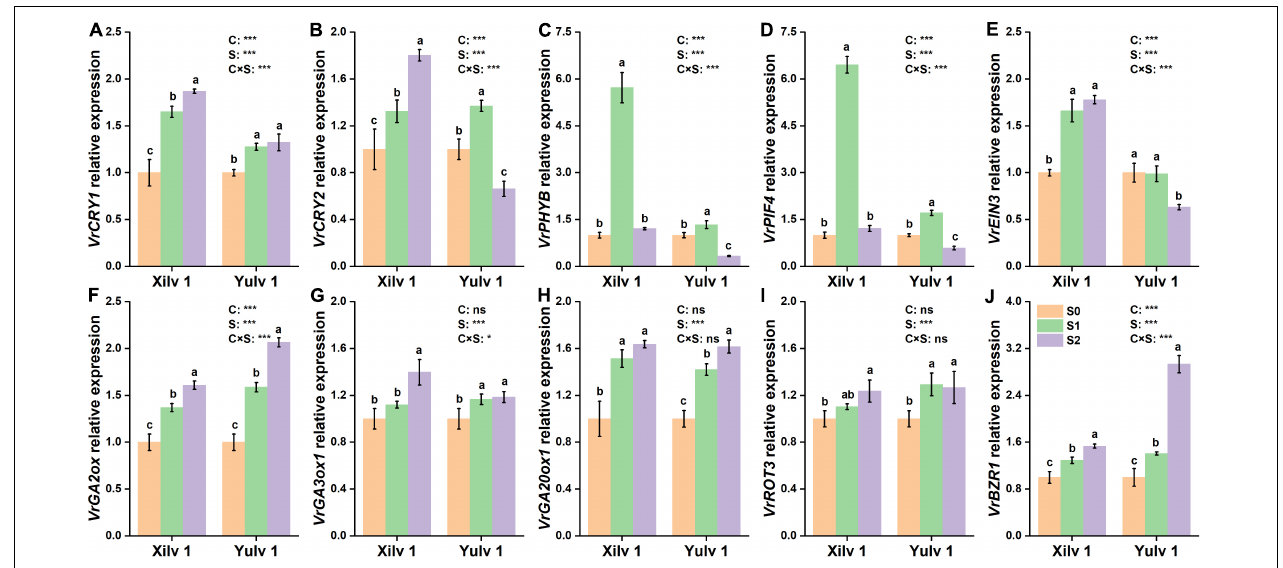
FIGURE 8 | Effect of shading stress on the relative expressions of key leaf genes in mung bean. (A) VrCRY1 ; (B) VrCRY2 ; (C) VrPHYB ; (D) VrPIF4 ; (E) VrEIN3 ; (F) VrGA2ox ; (G) , VrGA3ox1 ; (H) VrGA20ox1 ; (I) VrROT3 ; and (J) VrBZR1 . Values followed by a different letter are significantly different at p < 0.05. S0, no shading; S1, moderate shading; and S2, severe shading. * and *** significant at the 0.05 and 0.001 probability levels, respectively. ns, no significant